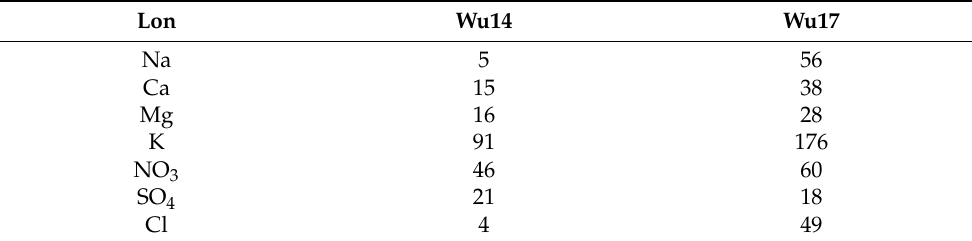
Table 3. The share of atmospheric input (%) in the total stream output in the Wüstebach (Wu14) and control catchment